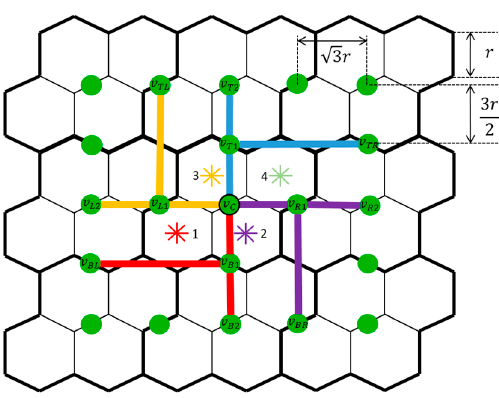
Figure 3. Possible MST vertices and edges surrounding a coarse cell. Algorithm 1: clockwiseCircumnavigationPathGeneration